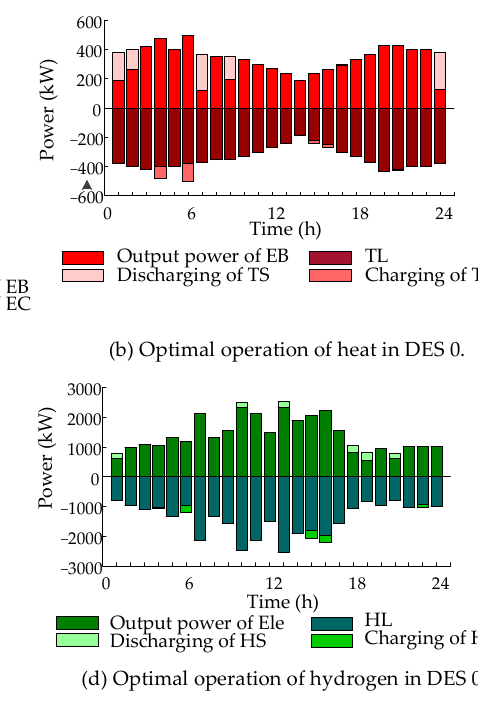
Figure 8. Optimal operation in DES 0.